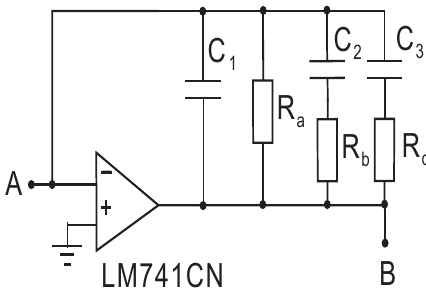
Figure 2. The circuit unit to realize 1